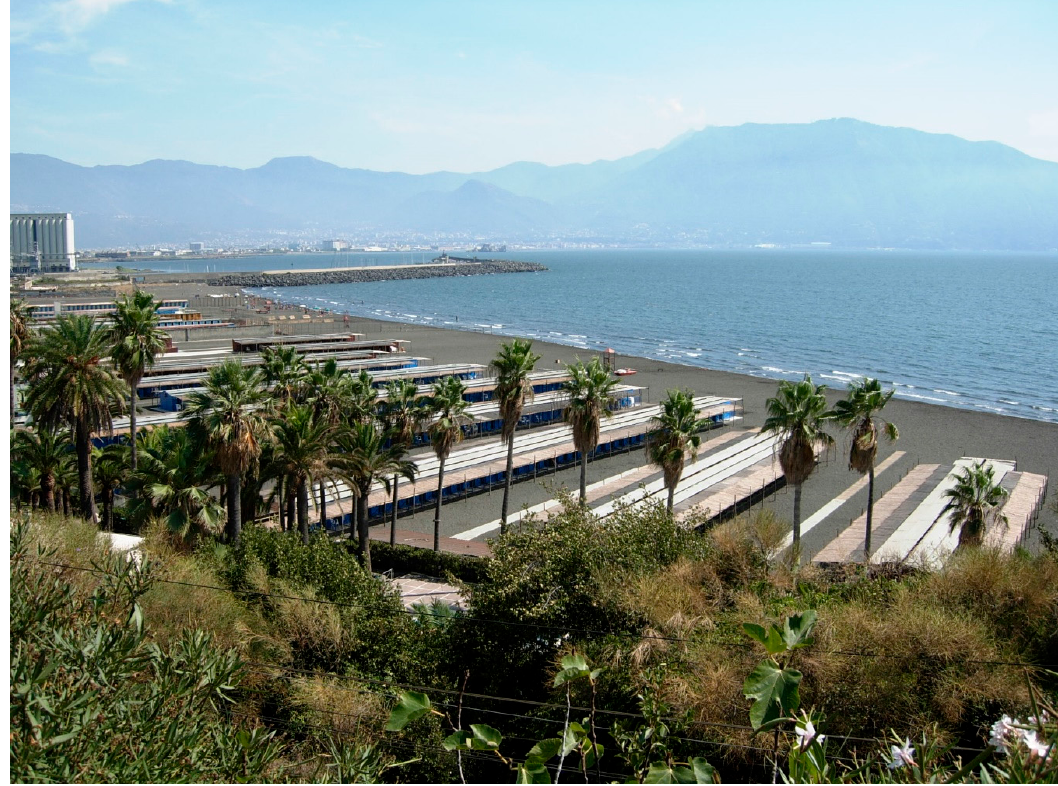
Figure 7. Panoramic view of the 200 m-wide new sandy beach of the Torre Annunziata showing a triangular shape.